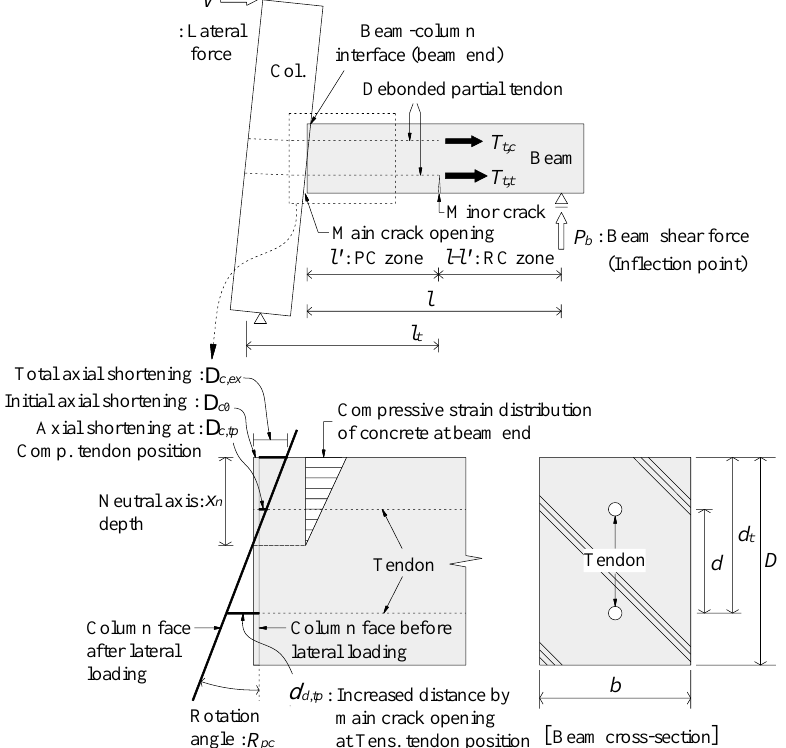
Figure 3. Analytical model of exterior beam – column connection subassemblage of PC frame with debonded partial tendons.